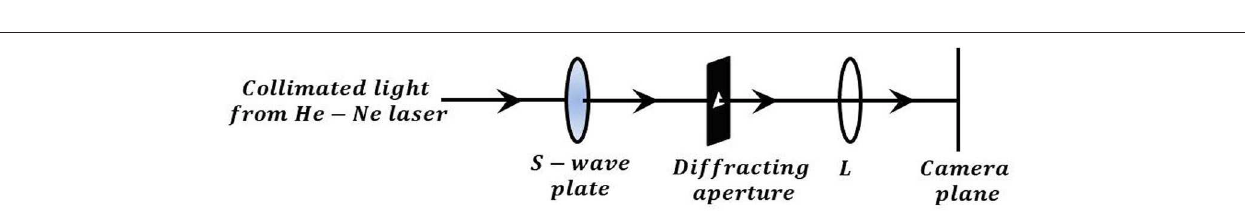
[64], right triangular aperture [60], and circular aperture